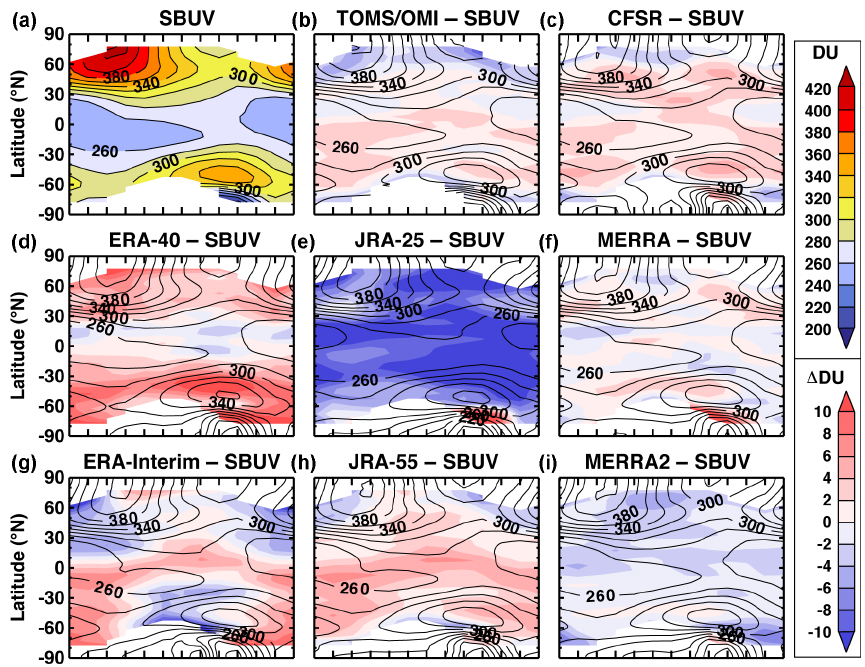
Figure 3. Zonal and monthly mean total column ozone climatology over 1981–2010 from SBUV observations (a) , along with the absolute differences between each reanalysis and SBUV. The difference between TOMS/OMI and SBUV is also shown (b) . (c–i) Line contours show each reanalysis’ respective climatology, and the shading shows differences from SBUV, with cool (blue) colors representing negative values and warm (red) colors representing positive values. Both climatology and observational references to calculate differences for ERA-40 are for the time period January 1981–August 2002 in order to avoid sampling